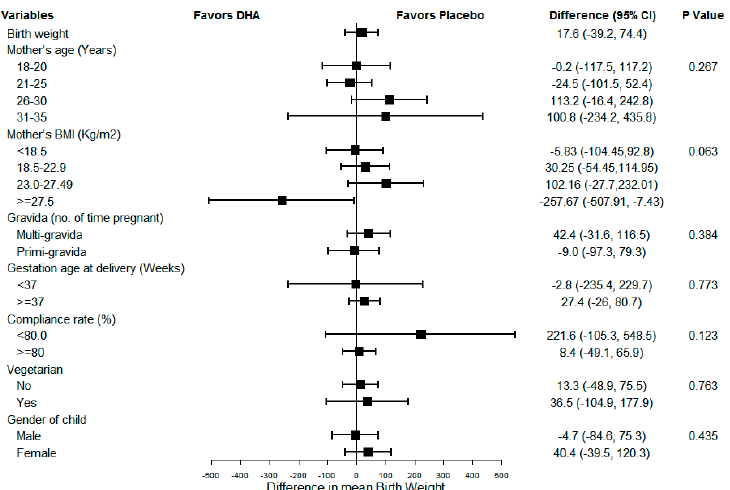
Figure 2. Sub-group analysis for newborn birthweight.